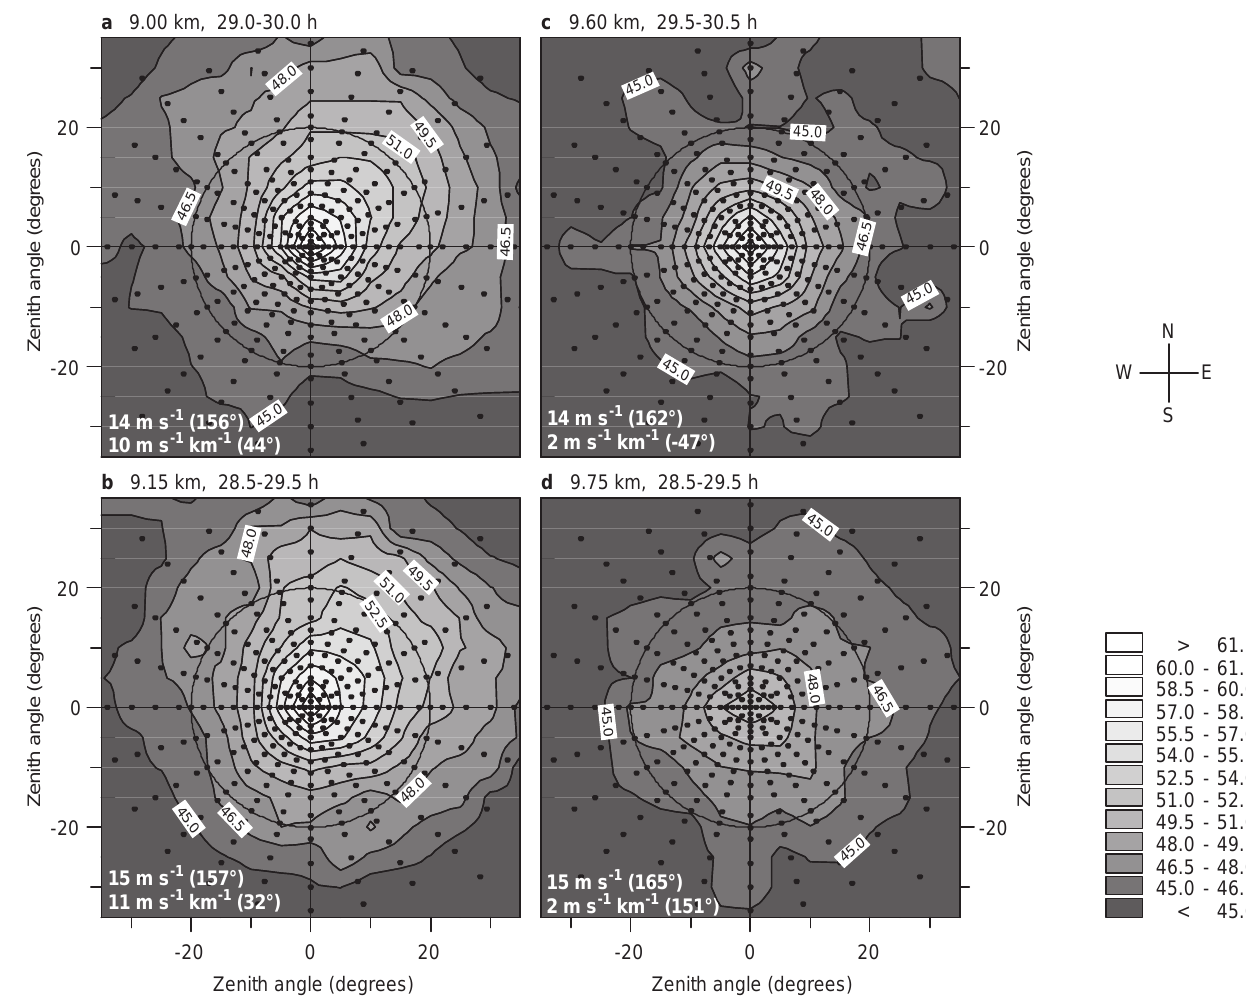
skewed in the direction of the windshear (Fig. 2b). A reference circle shows a zenith angle of 20 (cid:176) . The mean magnitude and direction of the horizontal wind speed and shear are printed for each power map. The shear is measured over a height interval of 300 m, using the height gate above and below that of the echo